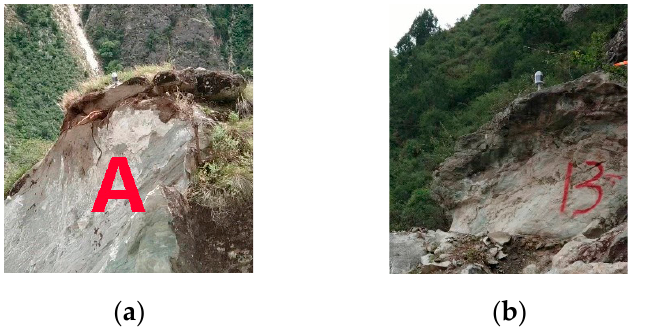
Figure 9. Perilous rocks. ( a ) A is a perilous rock on the open-top landslide; ( b ) B is a perilous rock on the open-top landslide near A. Table 4. Parameter indexes of the perilous rocks.